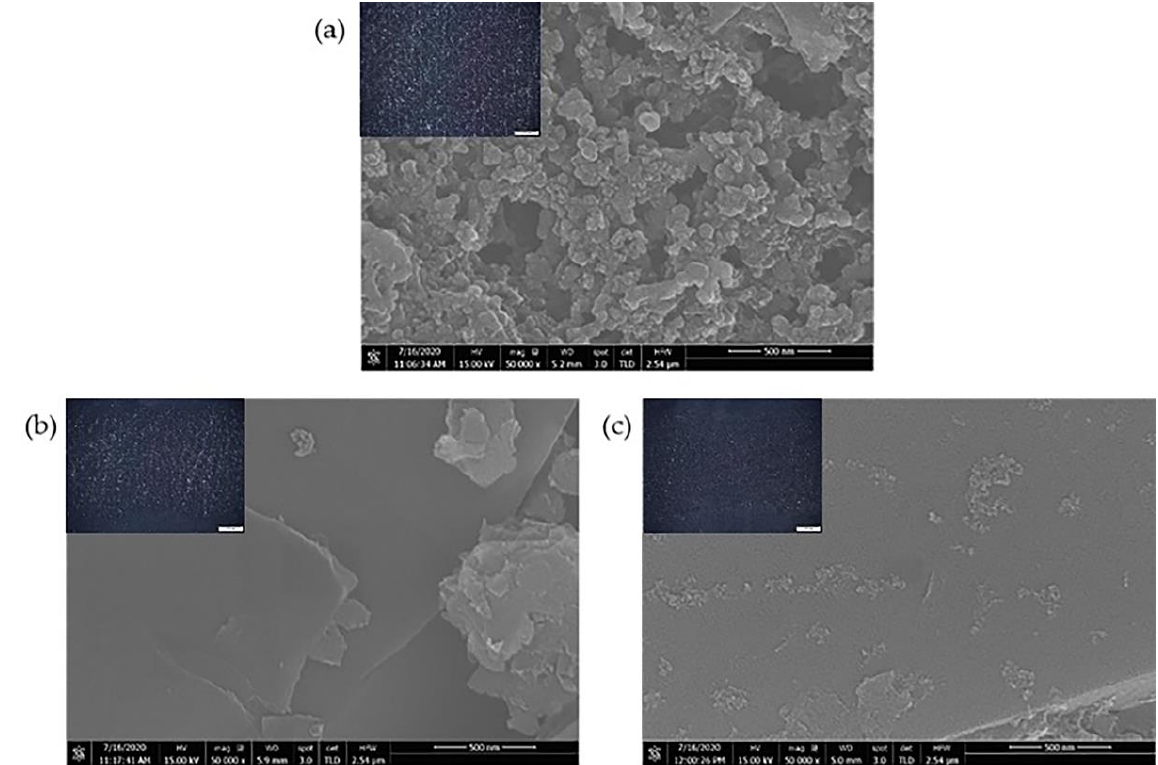
Figure 1. SEM images of bare SPCE ( a ), rGO/SPCE ( b ), and rGO-methionine/SPCE ( c ). The insets of ( a – c ) are the stereomicroscopic at 10× magnificent of bare SPCE rGO/SPCE and rGO-methionine/SPCE, respectively.